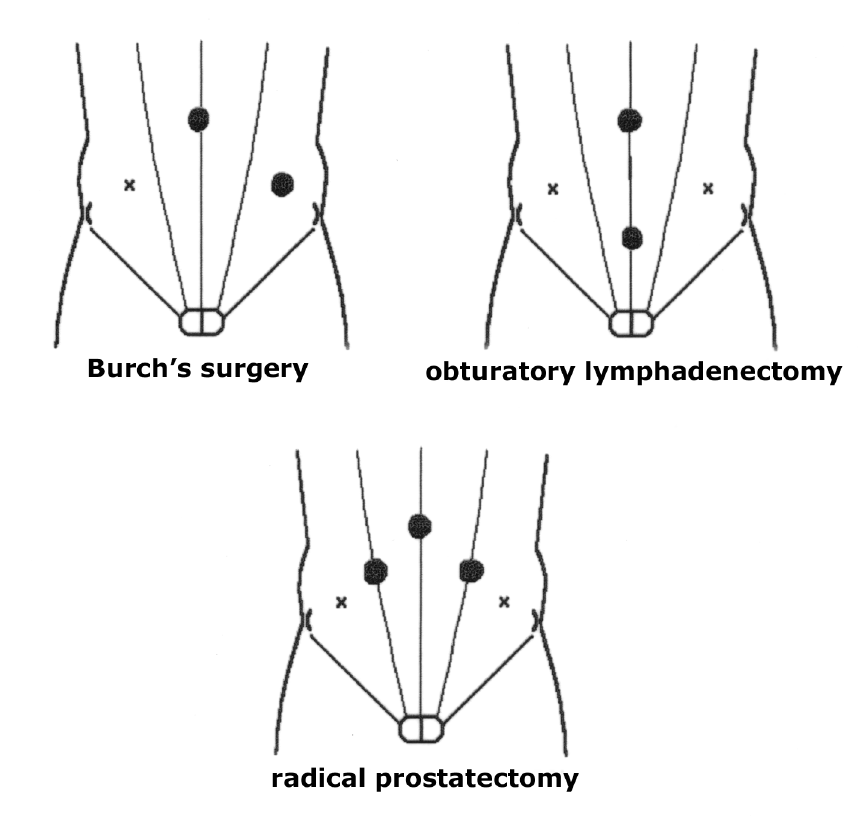
Figure 9 – Positioning of the ports in the pelvic region according to the procedure. = 10 mm port; x = 5 mm